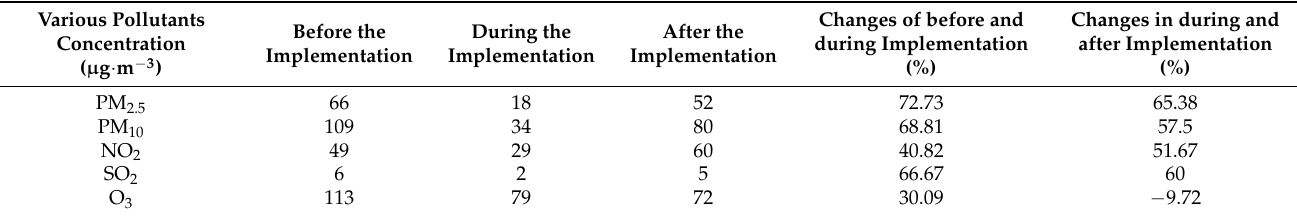
Table 2. Changes in pollutants in the Olympic Sports Center monitoring